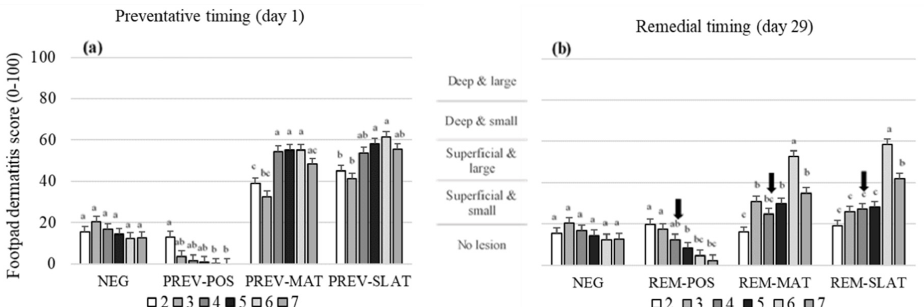
Figure 2. Mean footpad dermatitis scores (raw means ± SEM) of birds that received ( a )